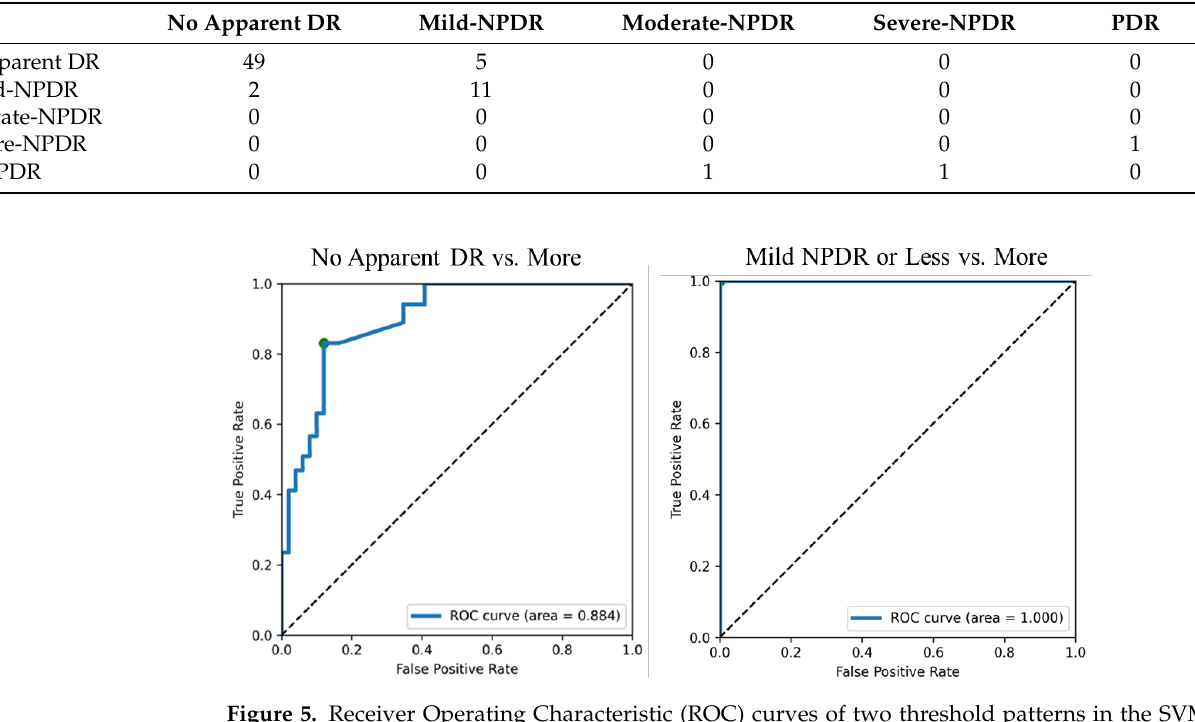
Figure 5. Receiver Operating Characteristic (ROC) curves of two threshold patterns in the SVM classification of 70 eyes of patients attending a diabetes clinic and not scheduled for an eye clinic visit. The classification with mild NPDR as the threshold showed the highest AUC of 1.0 (SVM means support vector machine).